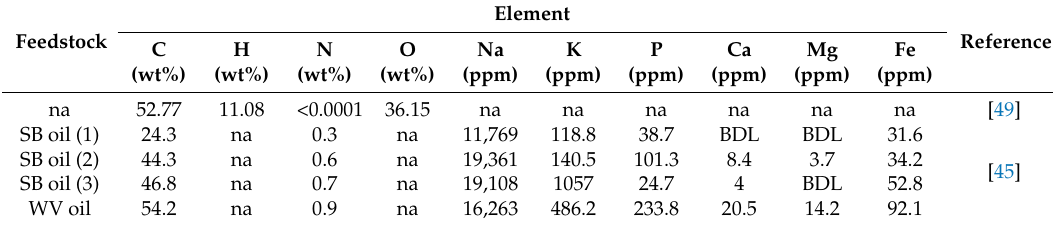
Table 4. Elemental analysis of a typical crude glycerol produced in biodiesel industry (adapted from different authors).